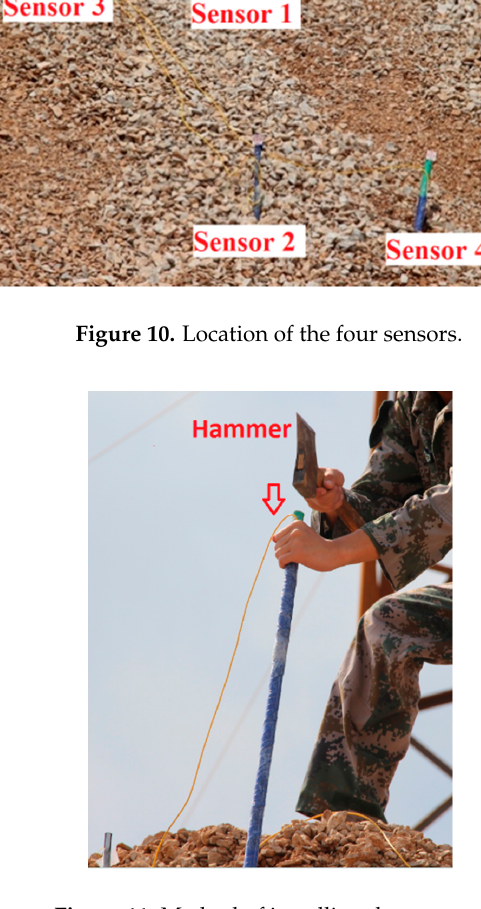
Figure 11. Method of installing the sensors.